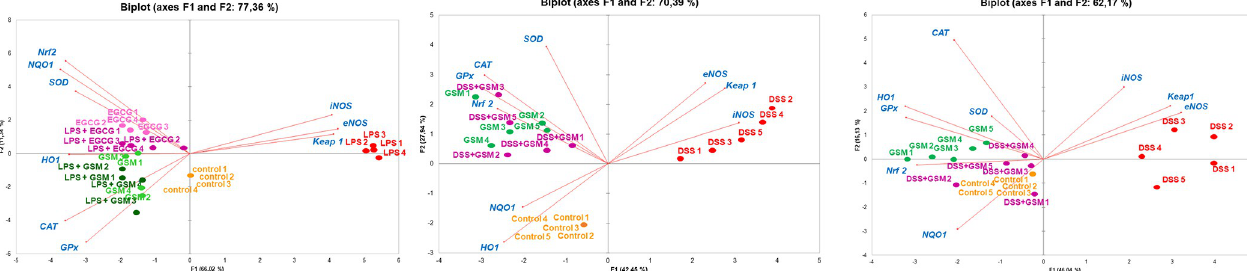
Fig 8. Principal component plots experimental groups with antioxidant genes based on qPCR data set in IPEC-1 cells (A), colon (B) and mesenteric lymph nodes (C). The loading plot with differentially expressed genes in relation to the largest portion of the variance among experimental groups.